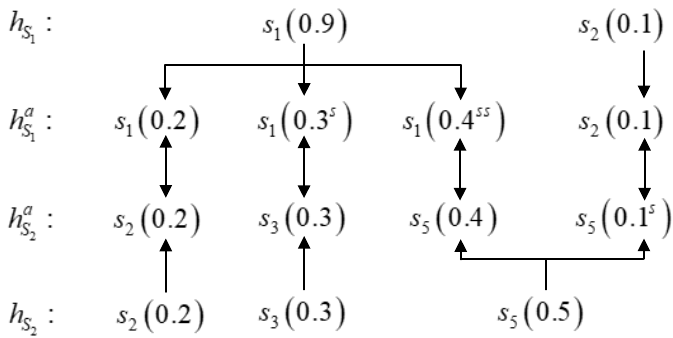
Figure 1. The calculation procedure of adjustment.